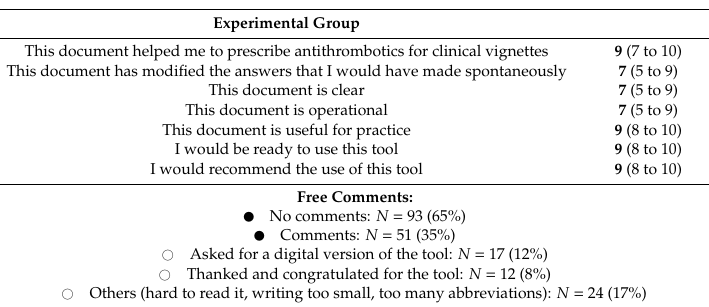
Table 3. Evaluation of the prescription support tool reported by 144 physicians randomized to the experimental group (scores out of 10). Values are medians